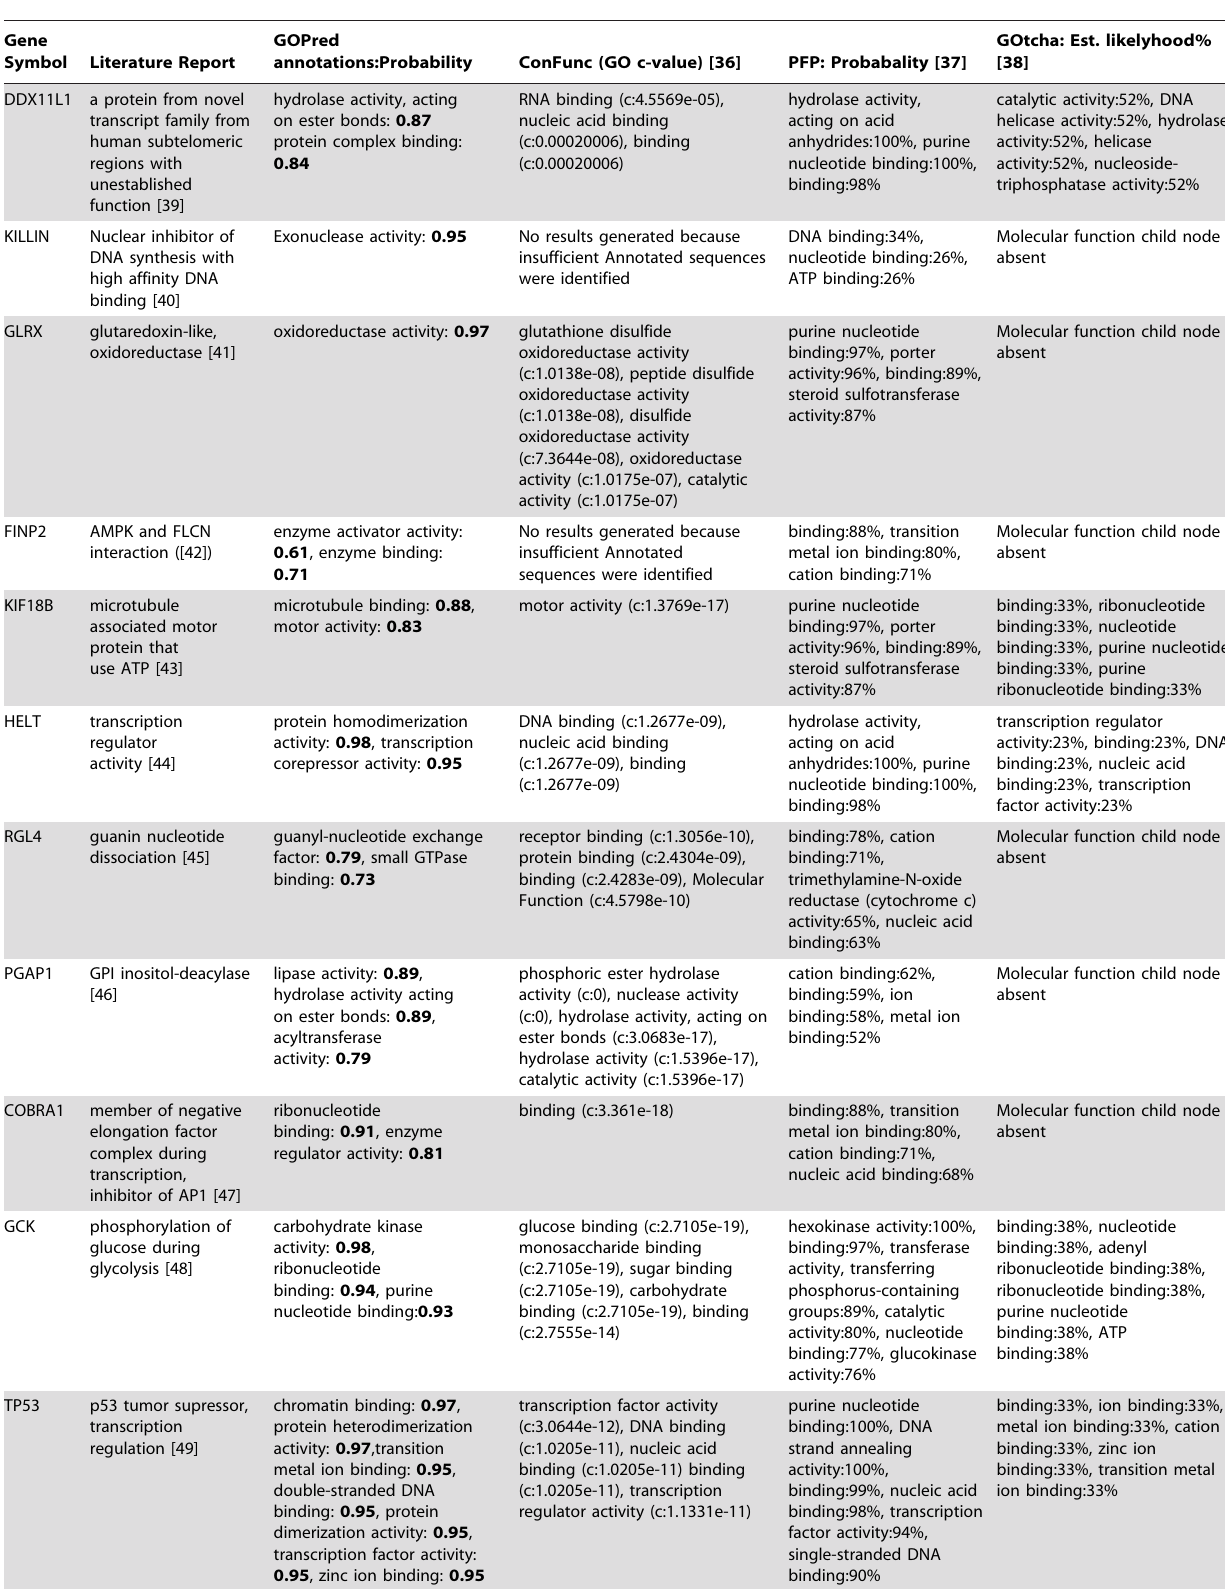
Table 5. GOPred, ConFunc, PFP and GOtcha annotations for 12 human gene entries from the NCBI gene database.